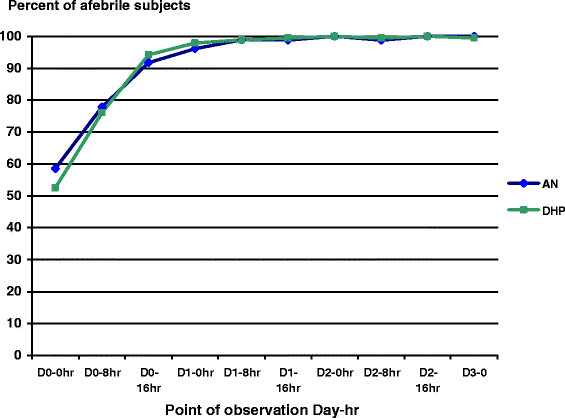
Proportions of afebrile malaria subject treated with artemisinin-naphthoquine (AN) versus dihydroartemisinin-piperaquine (DHP) groups were similar by point of observation (p > 0.05).